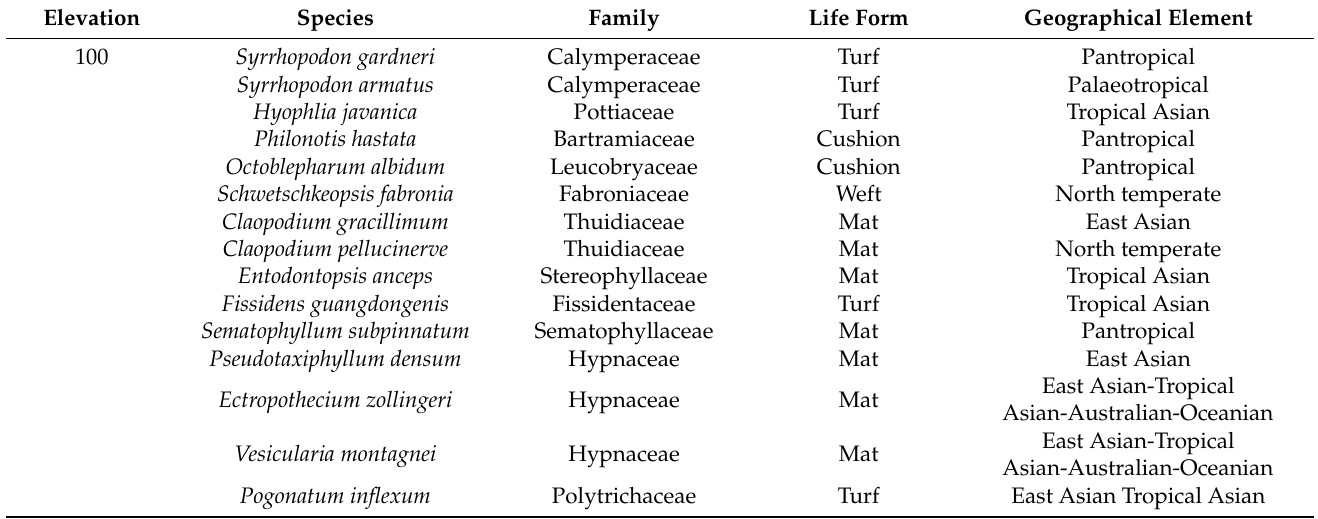
Table A1. Characteristics of terrestrial mosses along altitudinal